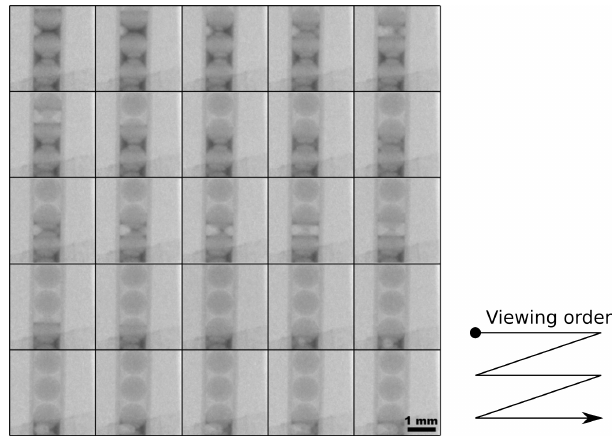
Figure 3. Time series of the evaporation of water from a model porous medium sample. The field of view is approximately 3 × 3mm 2 . The images were acquired with 6µm pixel size (4 × binning) using 90s acquisition time. Only every 10th image is pre- sented; therefore the time gap between the individual presented im- age is about 15min. The slightly darker trapezoidal object in the bottom right FOV is hydrogenous material within adhesive alu- minum tape used for the sample